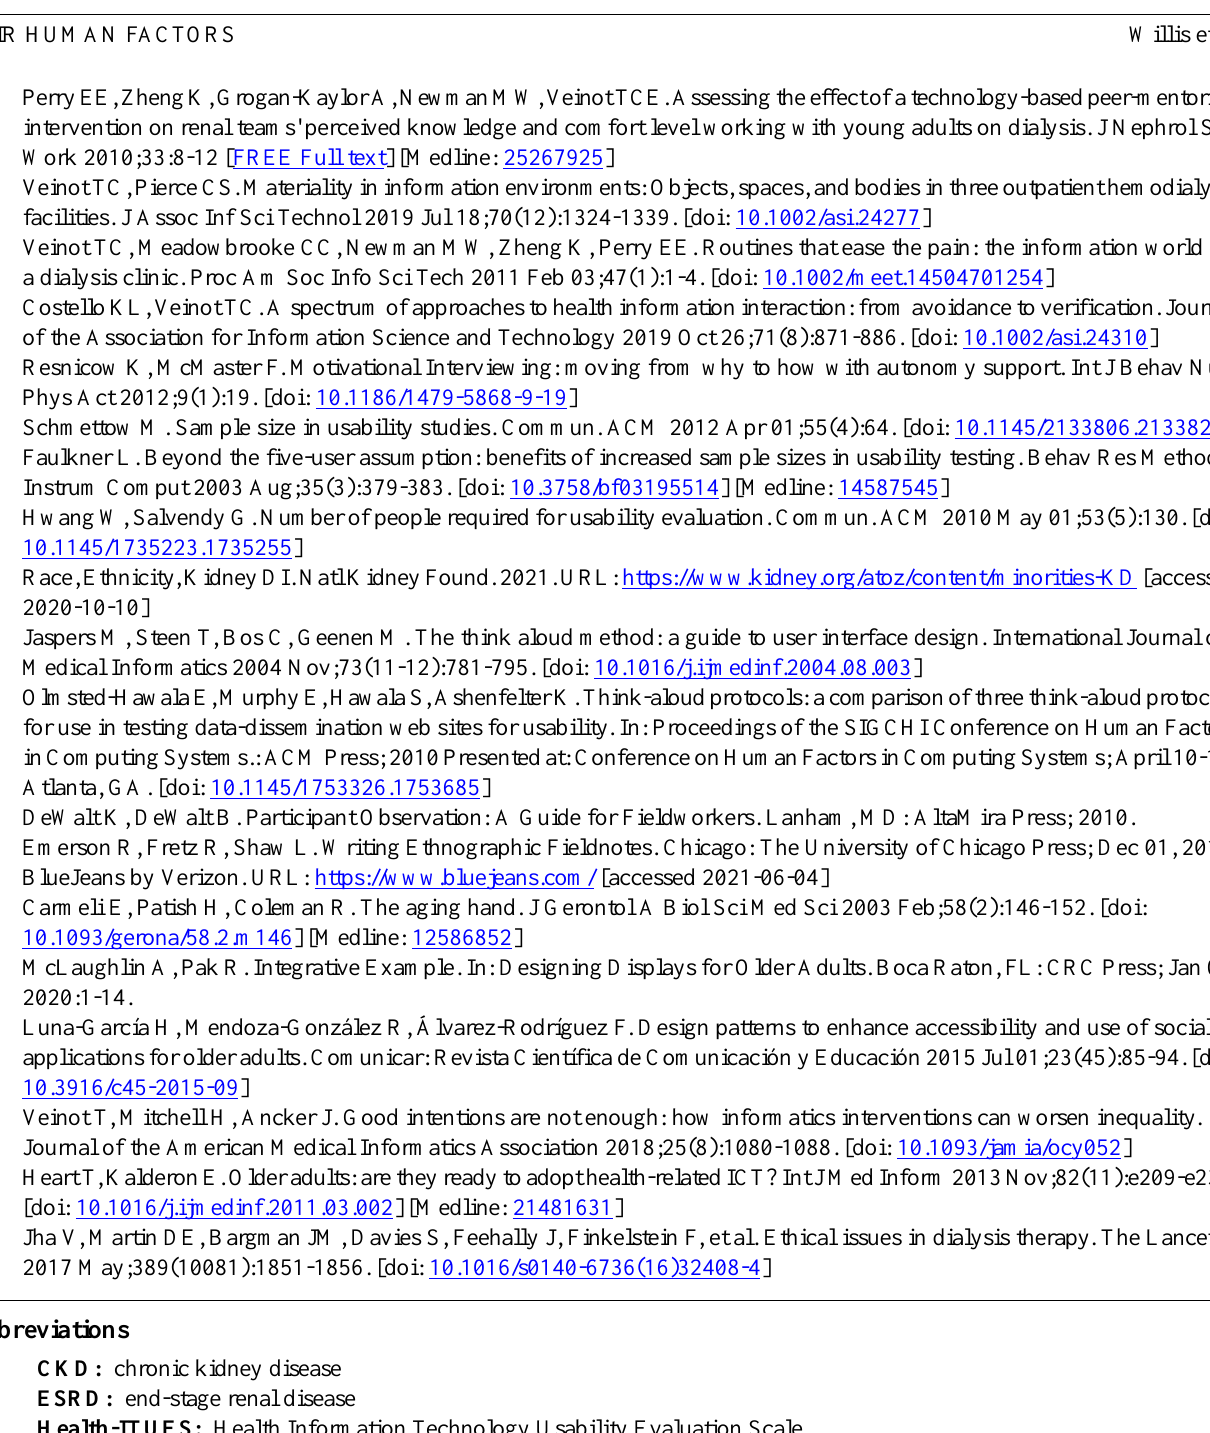
CKD: chronic kidney disease ESRD: end-stage renal disease Health-ITUES: Health Information Technology Usability Evaluation Scale IDH: intradialytic